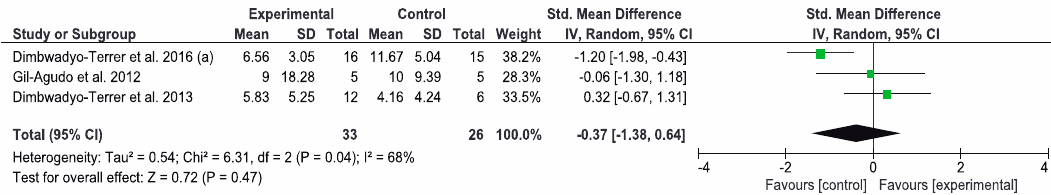
Figure 7. Forest plot for functional performance measured by Barthel index. A green block indicates the weight assigned to the study and the horizontal line depicts the confidence interval. A black rhombus shows the overall result.